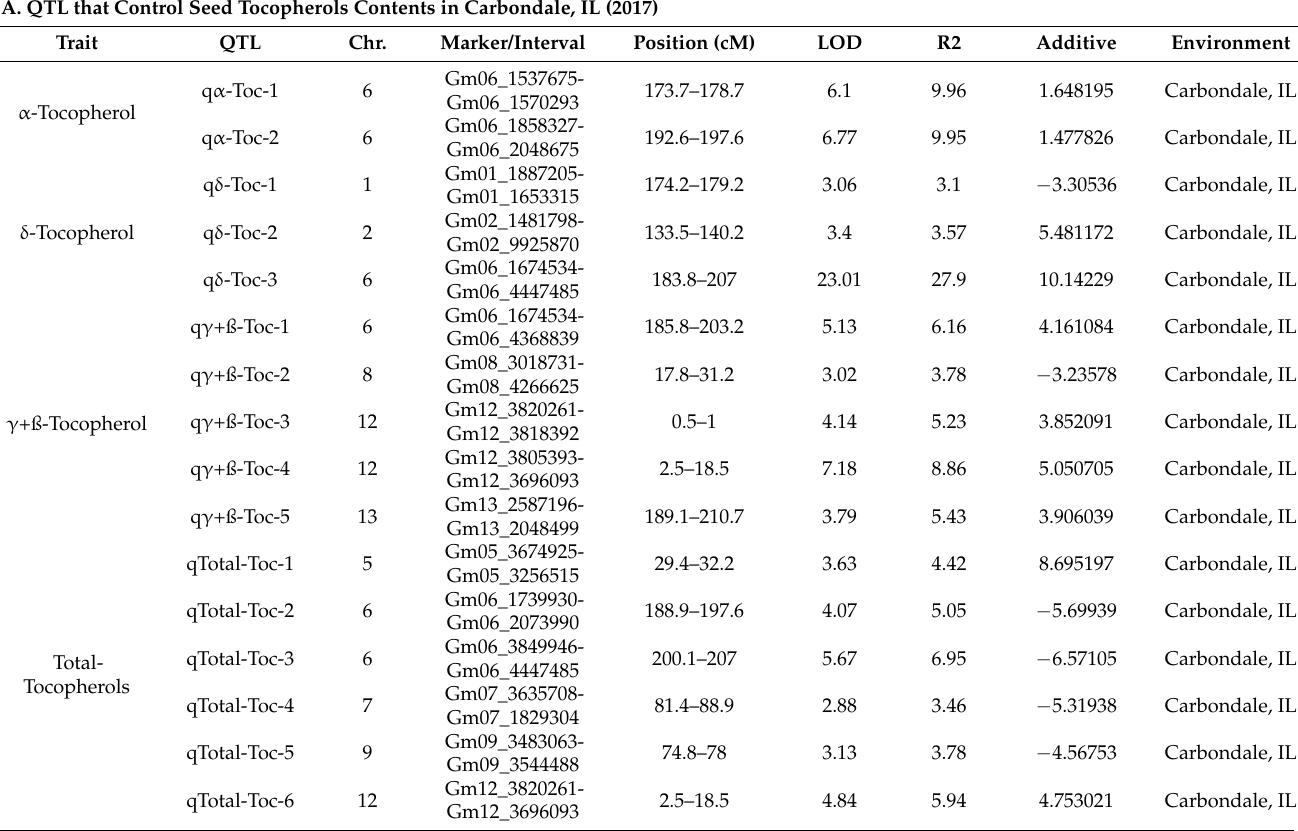
Table 3. QTLs that control seed α -Tocopherol ( α -Toc), δ -Tocopherol ( δ -Toc), ( α +ß)-Tocopherol (( α +ß)- Toc), and Total-Tocopherols (T-Toc) contents in two environments over two years (A. 2017 and B. 2020). The two environments are in Carbondale, IL (2017) (A) and (2020) (B). Only solid QTL with LOD scores >2.5 and identified by CIM are